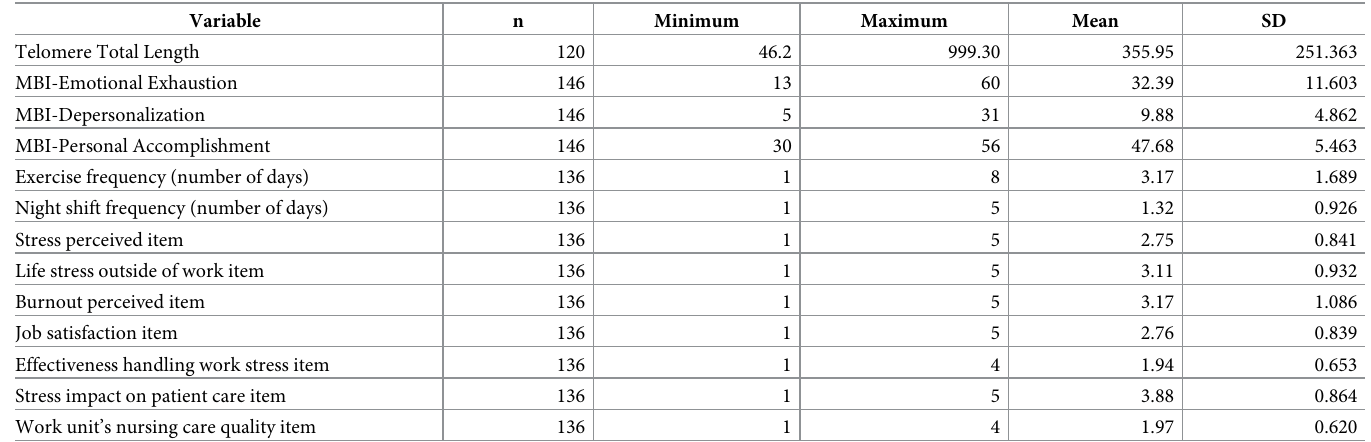
Table 2. Descriptive statistics for the study variables.